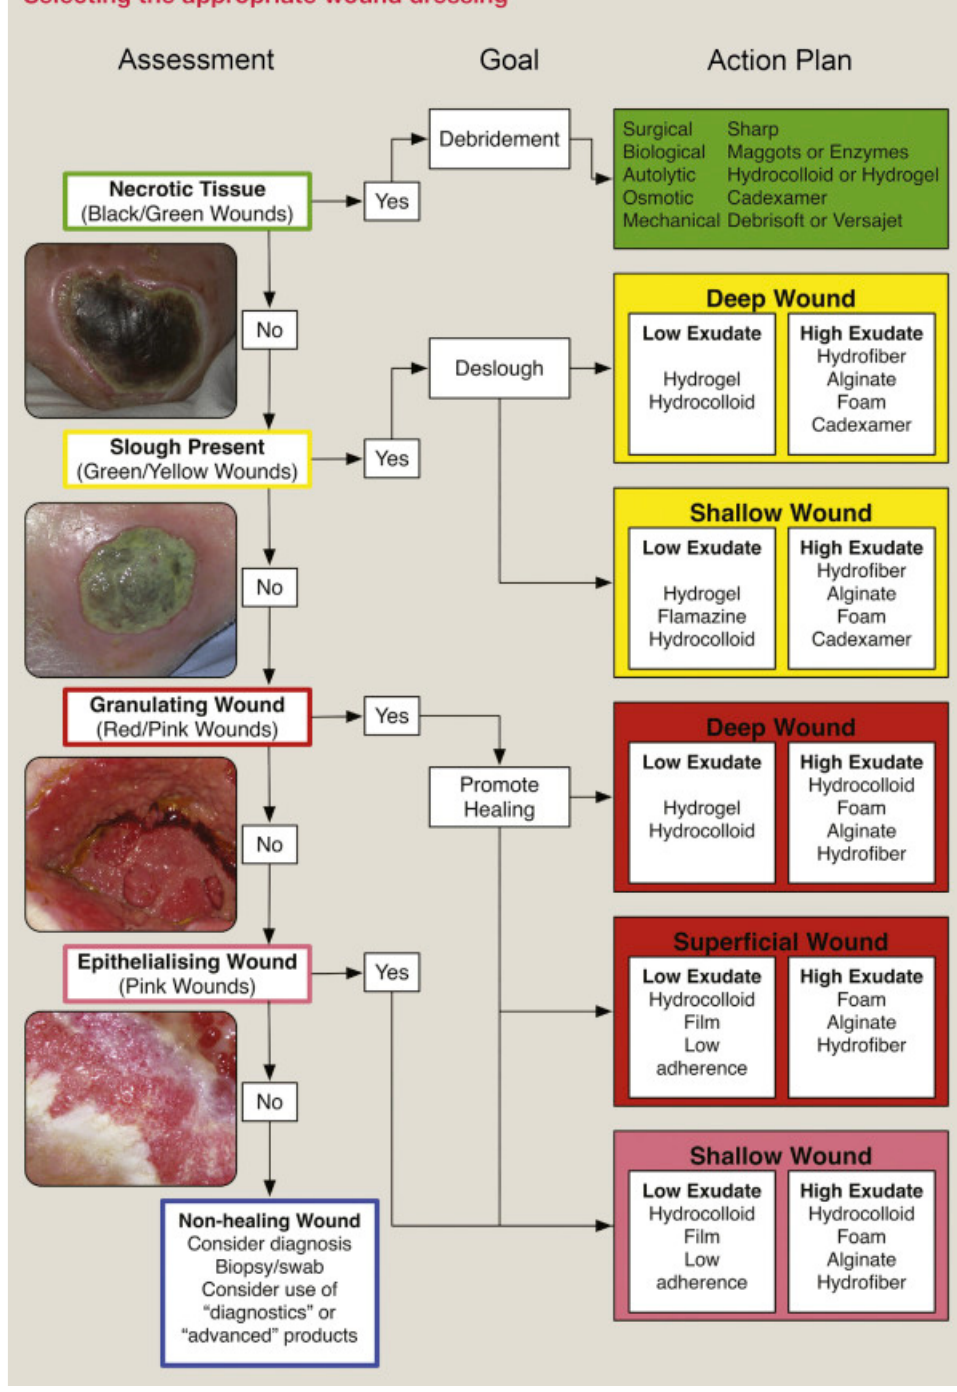
Figure 1. Selection of the appropriate wound dressing. Reproduced from [13] with permission.